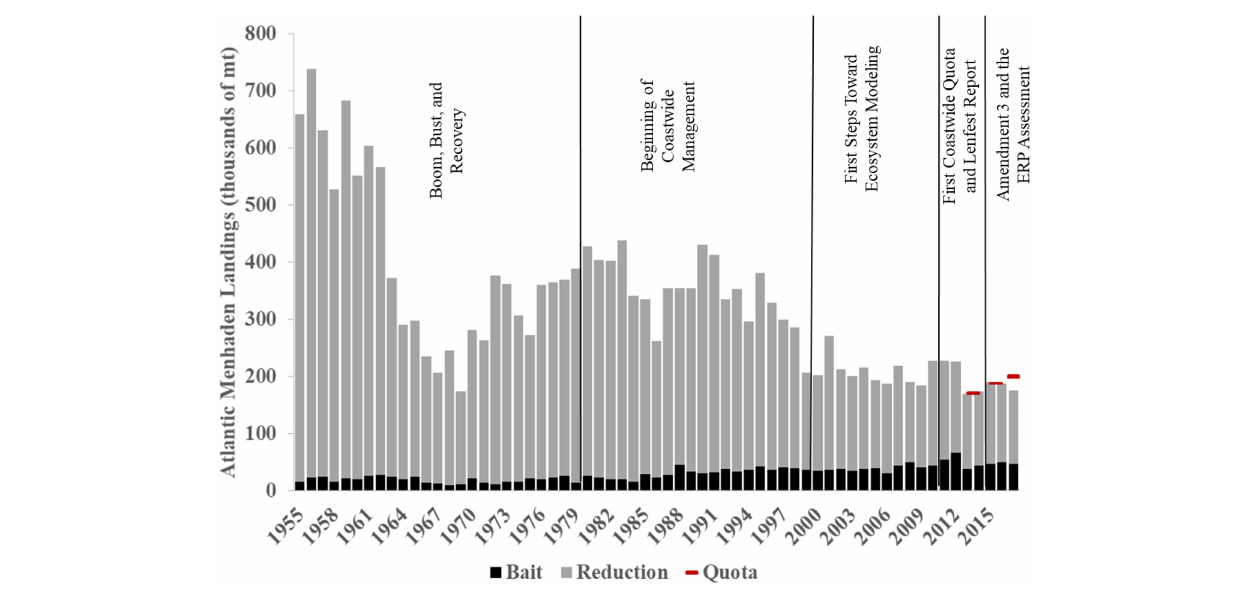
FIGURE 2 | Atlantic menhaden landings from the reduction and bait fisheries during each of the five periods of assessment and management history. Coastwide harvest quotas began in 2013 and are indicated on the graph in red.